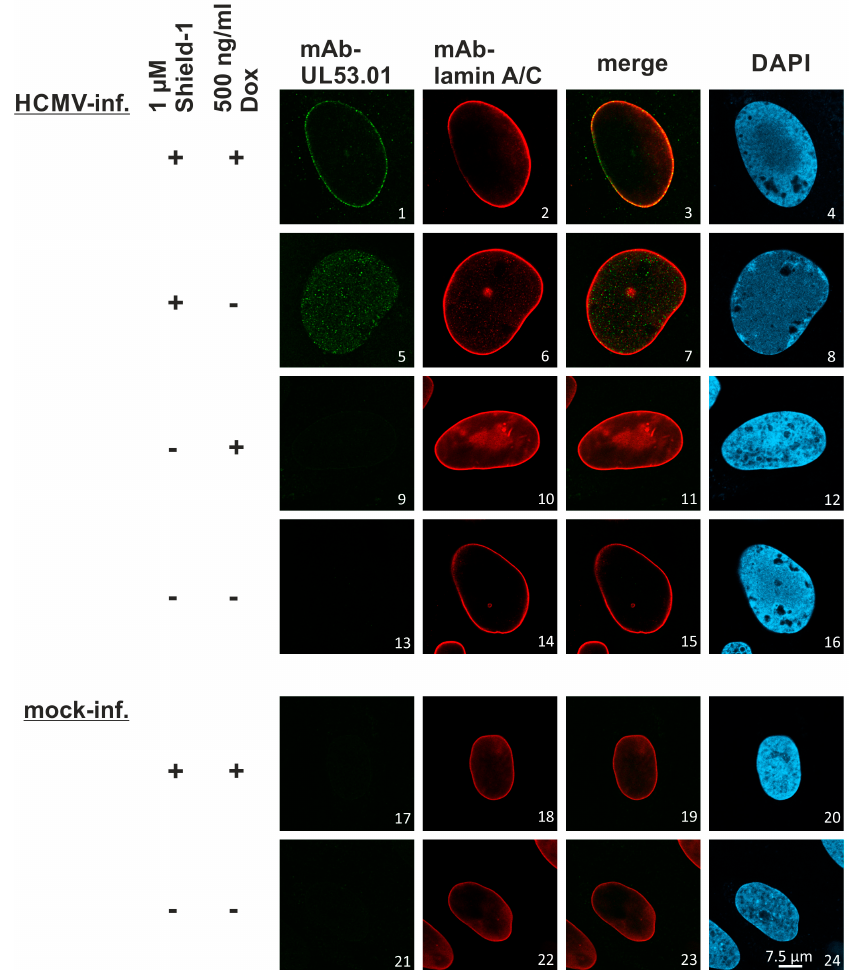
Figure 14. Shield-1- and Dox-controlled expression of viral core NEC proteins during HCMV ∆ UL50- Σ UL53 infection. HFF-UL50 cells were infected with HCMV ∆ UL50- Σ UL53 at MOI of 0.3. To analyze the experimental controllability of viral core NEC expression and intranuclear localization, 1 µM of Shield-1 and/or 500 ng/mL of Dox (refreshed every second day) were added as indicated. Uninfected cells served as a negative control (mock). At 6 d p.i., cells were fixed, used for an immunofluorescence staining by the indicated antibodies and analyzed by confocal imaging. Lamin A/C-specific counterstaining was used as a marker of the nuclear rim, representing the typical localization site of viral pUL50–pUL53 recruitment; DAPI counterstaining was used to monitor the morphologies of cell nuclei. For raw data, see h tt ps://doi.org/10.5281/zenodo.7794233 accessed on 3 April 2023.